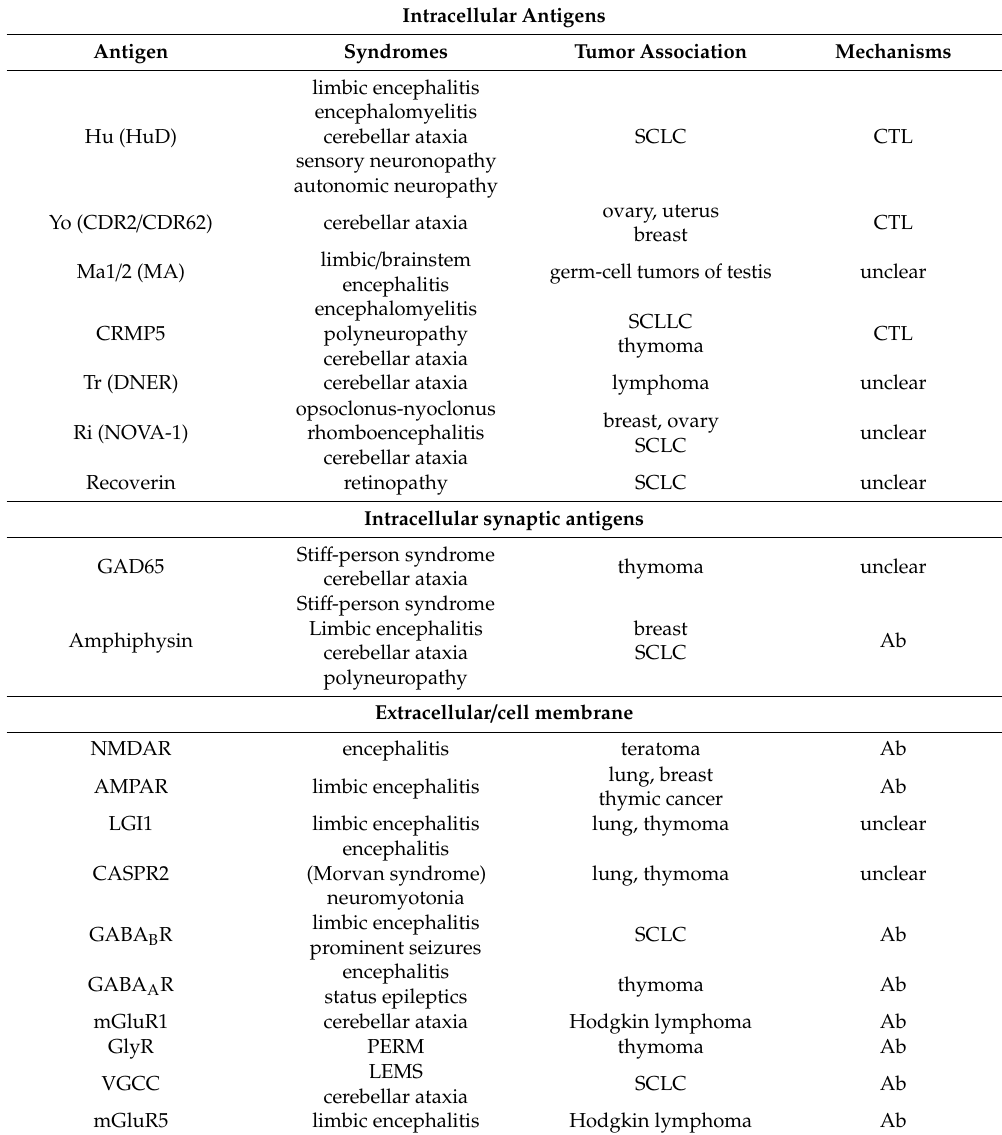
Table 1. Autoantibody targets and associated syndromes (modified from